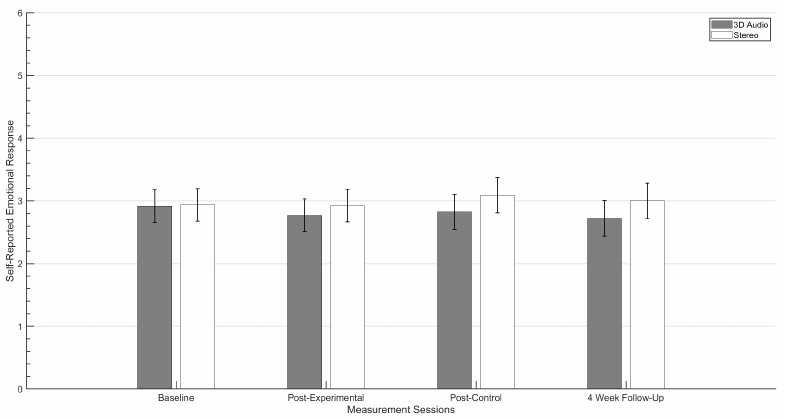
Figure 5. Mean self-reported emotional response to non-target stimuli for both experimental condi- tions. Whiskers denotes ±95% confidence intervals.